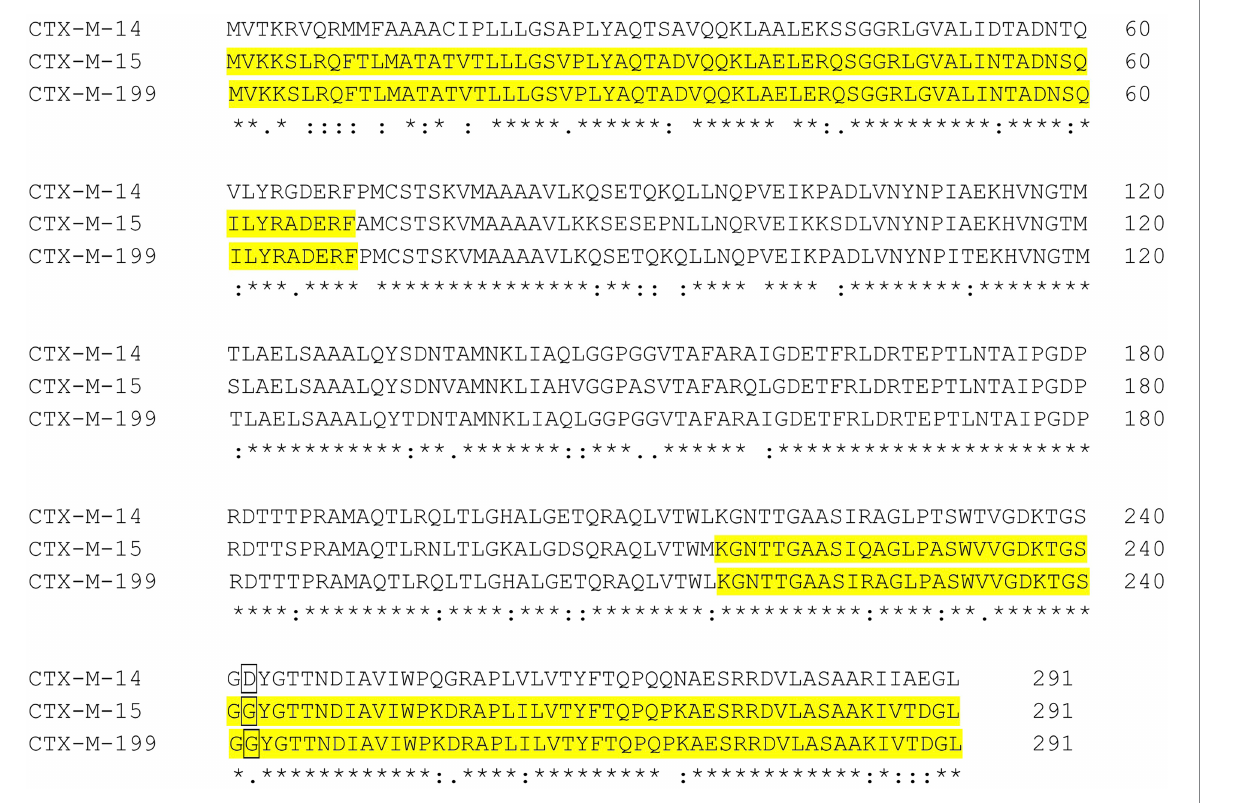
FIGURE 1 Alignment of CTX-M-14, CTX-M-15 and CTX-M-199. CTX-M-199 is a hybrid comprising the N- and C-termini of CTX-M-15 (highlighted in yellow) and the middle part of CTX-M-14. D in CTX-M-14 and G in CTX-M-15 and CTX-M-199 at the Amber position 240 are shown in framed letters. Position numbers shown in the figure are according to the start